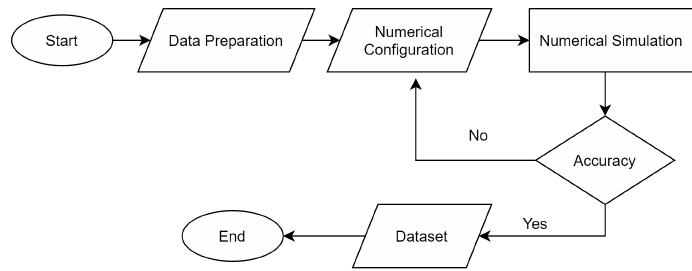
Figure 3. Flowchart of wave data